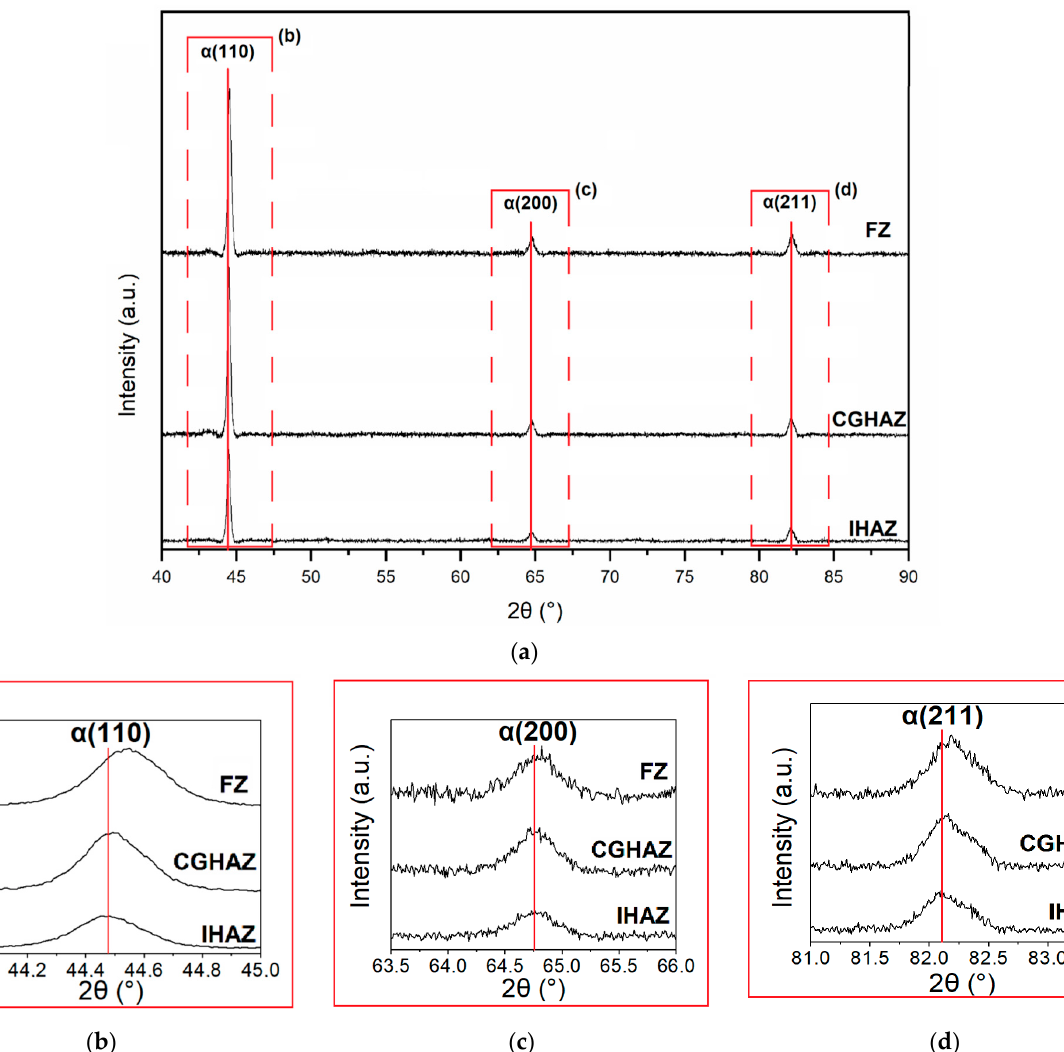
Figure 10. Comparison of ( a ) full XRD spectra of FZ, CGHAZ and IHAZ, ( b ) α (110) peaks, ( c ) α (200) peaks, and ( d ) α (211) peaks .